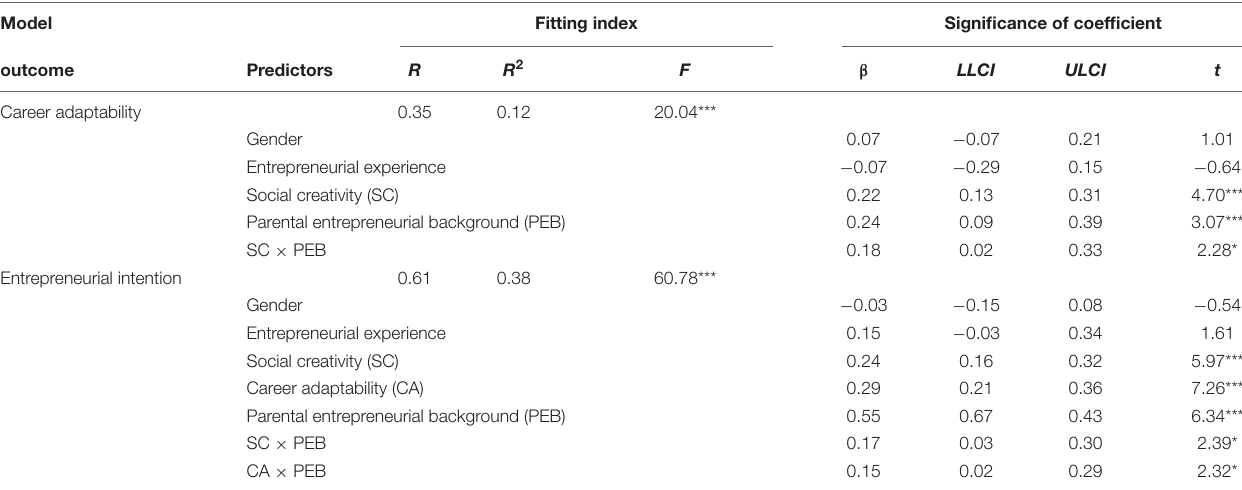
TABLE 3 | Testing the moderation model.